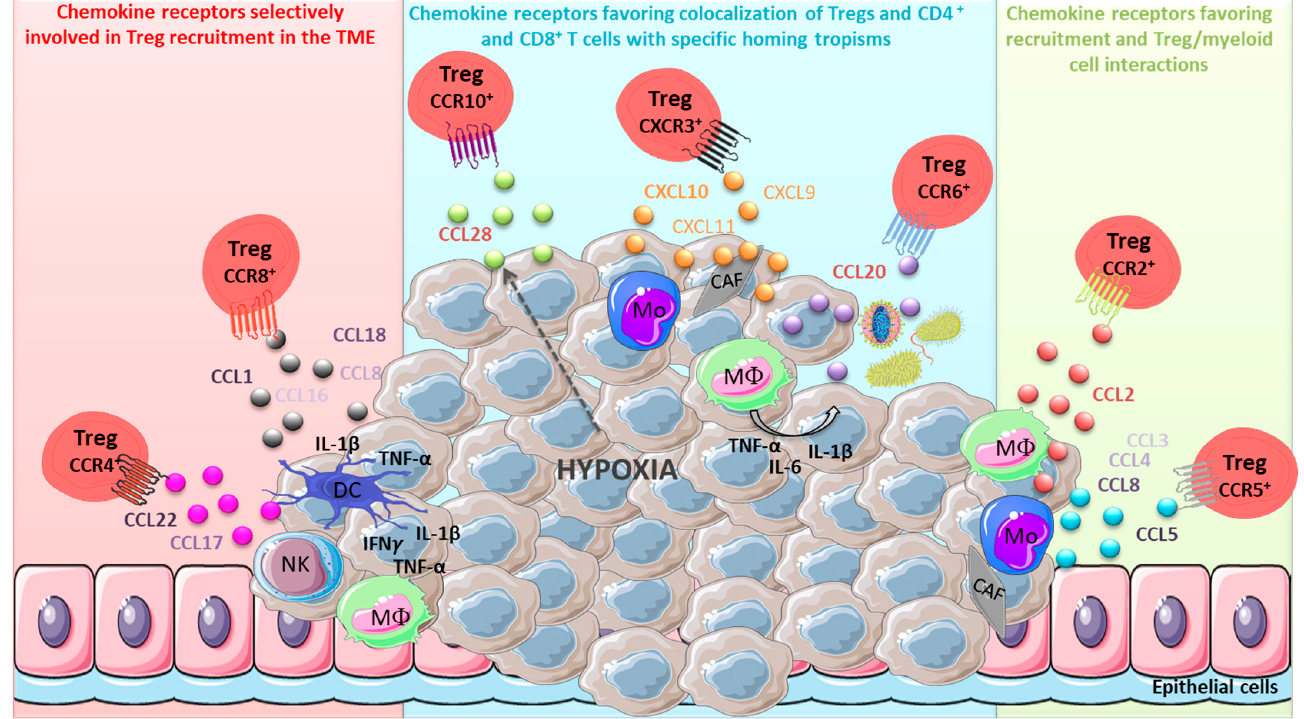
Figure 1. Chemokine/chemokine receptors axes involved in the recruitment of Tregs in the TME and the major mechanisms involved in the production of these chemokines in the TME. Several chemokine/chemokine receptors contribute to Treg recruitment at a tumor site according to their specific contexts; however, CCR4 and CCR8 appear as the most selectively expressed in TA-Tregs. NK: natural killer cells; M Φ : macrophages; Mo: monocytes; CAF: Cancer associated